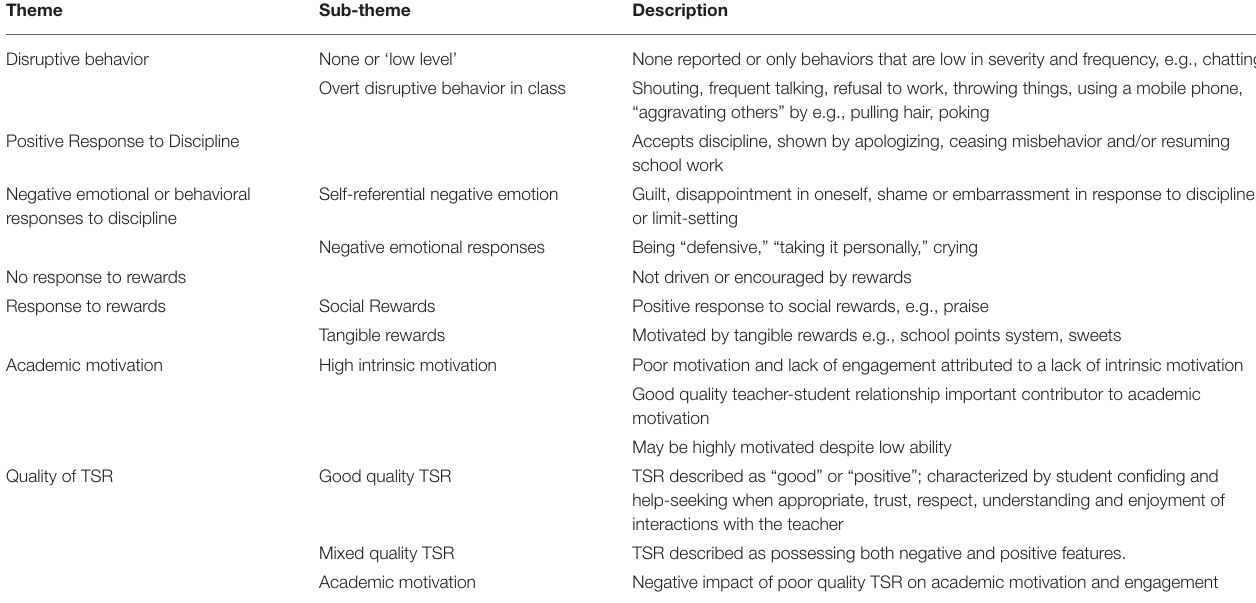
TABLE 4 | Qualitative findings for CU traits, disruptive behavior, response to rewards and discipline, academic motivation, and teacher-student relationship quality in low CU